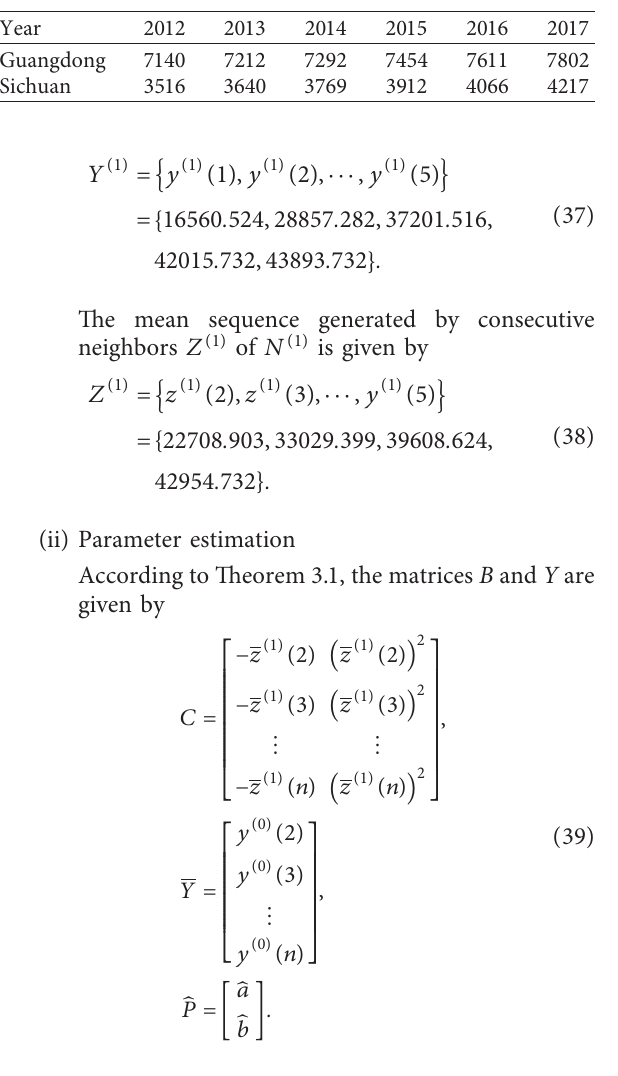
Table 5: Population of Guangdong and Sichuan from 2013 to 2017 (unit: ten